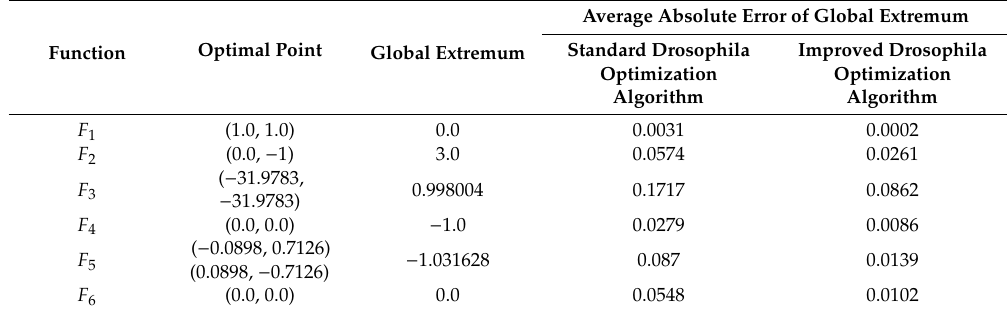
Table 3. Improvement of optimization performance of Drosophila optimization